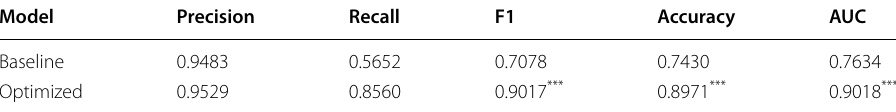
Table 8 Characteristic reading behaviors of high performance learners Reading behavior